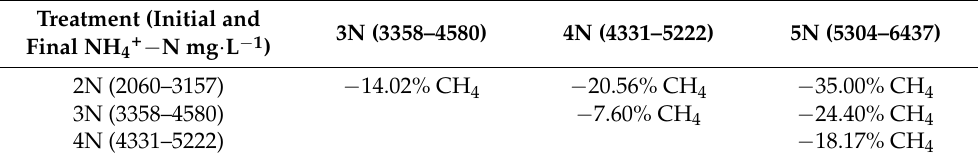
Figure 3. Accumulative methane production of co-digestion under different concentrations of ammonia. Different letters signify distinct statistical groups ( p < 0.05) between the different co-digestion samples. Table 5. Estimated methane reduction rates of the biogas plant’s substrates at different ranges of ammonia concentration.